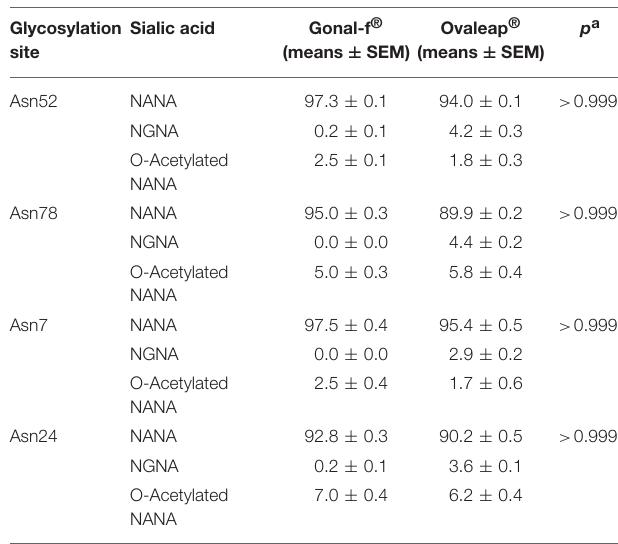
TABLE 4 | Sialic acid distribution in reference and biosimilar follitropin alfa preparations.